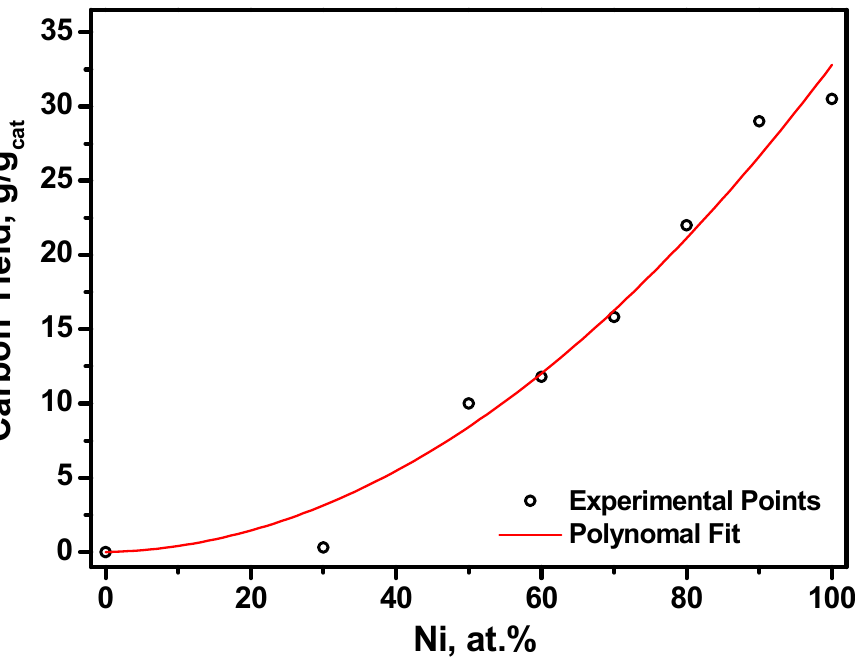
Figure 4. Dependence of the carbon yield (Y CNF ) in the ethylene decomposition reaction on the Ni content (at.%) in Pt 1 − x Ni x alloy. Data for the Ni 1.00 and Pt 1.00 samples are given for comparison. The reaction conditions are as follows: C 2 H 4 /H 2 /Ar, T = 600 °C, 15 min.